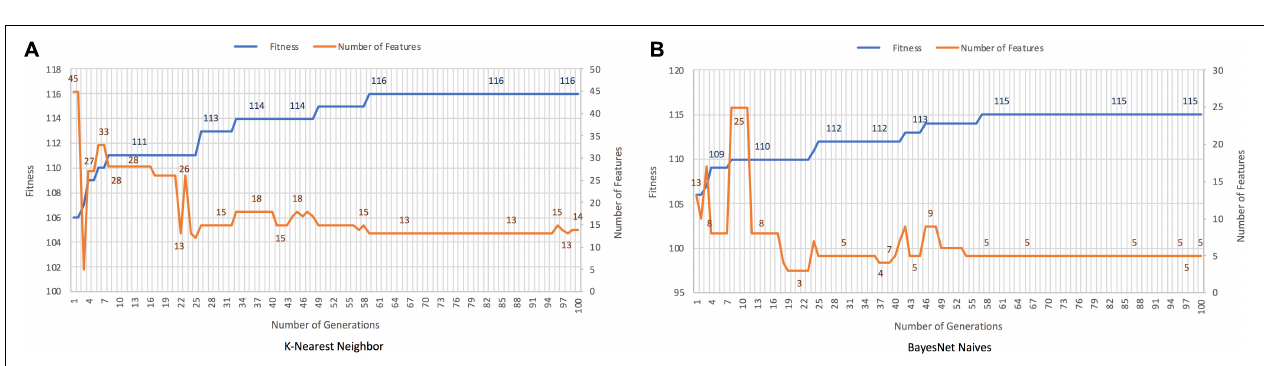
FIGURE 3 | Results for AD records vs. HCs with K-Nearest Neighbor (A) and BayesNet Naives (B) as the fitness function. The X axis represents the generations, the main Y axis corresponds to the fitness value, and the secondary Y axis shows the number of features selected. The blue line represents the progression of fitness and the orange line the smallest set of features in the current generation.